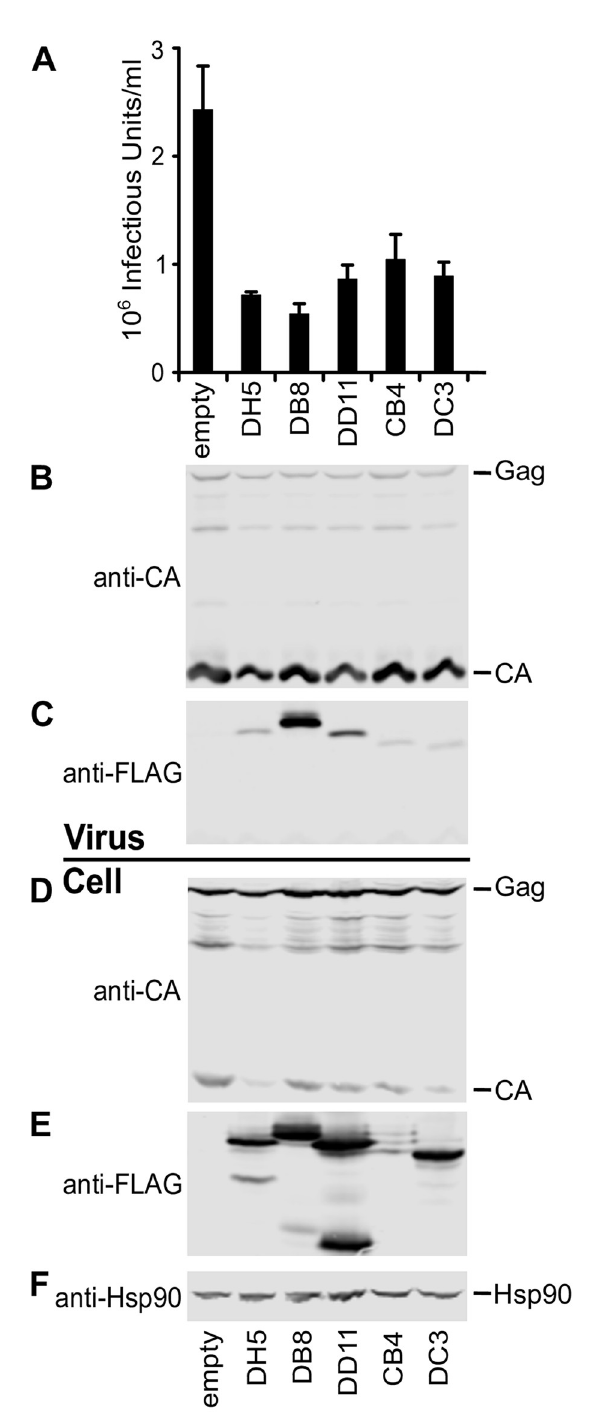
Fig 6. Effects of ESCRT-I binding protein expression on HIV-1 release and infectivity. Virus-producing cells were co-transfected with empty plasmid (labeled ‘Empty’), or antibodies DH5, DB8, DD11, CB4, and DC3 as described in material and methods. A . Infectious units released from transfected cells 293T cells, measured by titration on MT4 cells as described in material and methods. Error bars show the standard deviation of 3 independent experiments. B-F . Western blots. B . Western blot showing levels of virion-associated HIV Gag (Gag) and capsid (CA) proteins ( B , “Virus”), and antibodies incorporated into virions ( C , “Virus”). Designated intracellular viral and cellular proteins